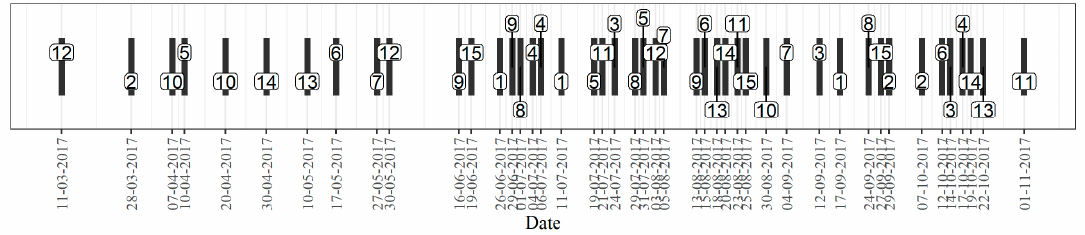
Figure 6. Images reduction. Numbers indicate iteration in which the image was removed.